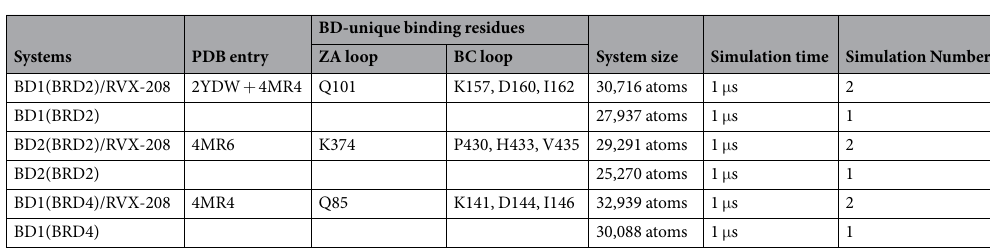
Table 1. The simulation systems in this study. (Note: The residue number used in each system is corresponding to that in RCSB Protein Data